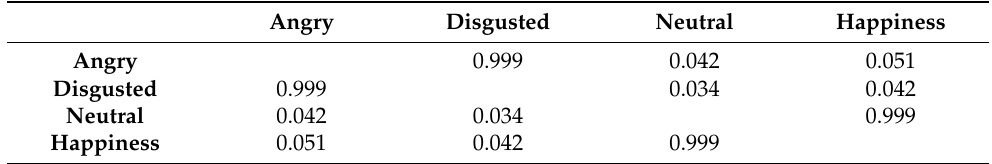
Figure 3. Main effect of the proposer’s offer on the mean acceptance rate. Different letters indicate significant differences. Table 1. p -values relative to Tukey’s post hoc comparisons between the four emotions and the accep- tance rate in all the experimental conditions.